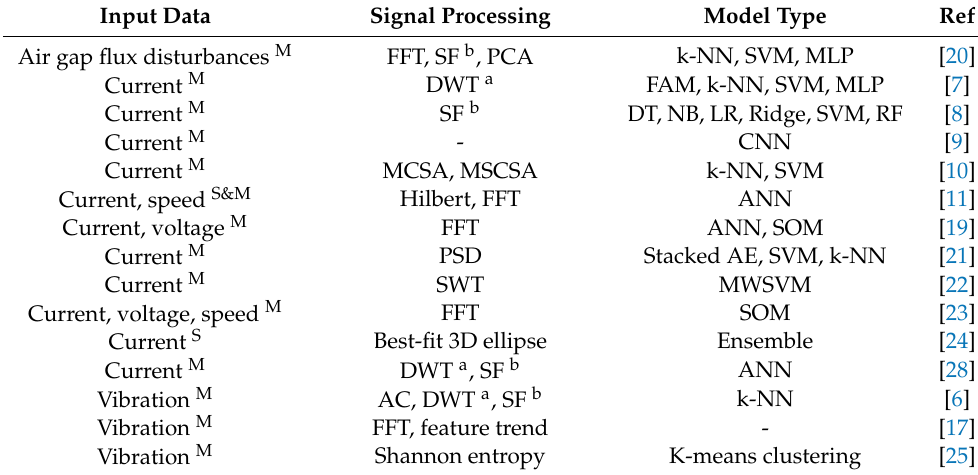
Table 1. Methods for detecting BRBs in